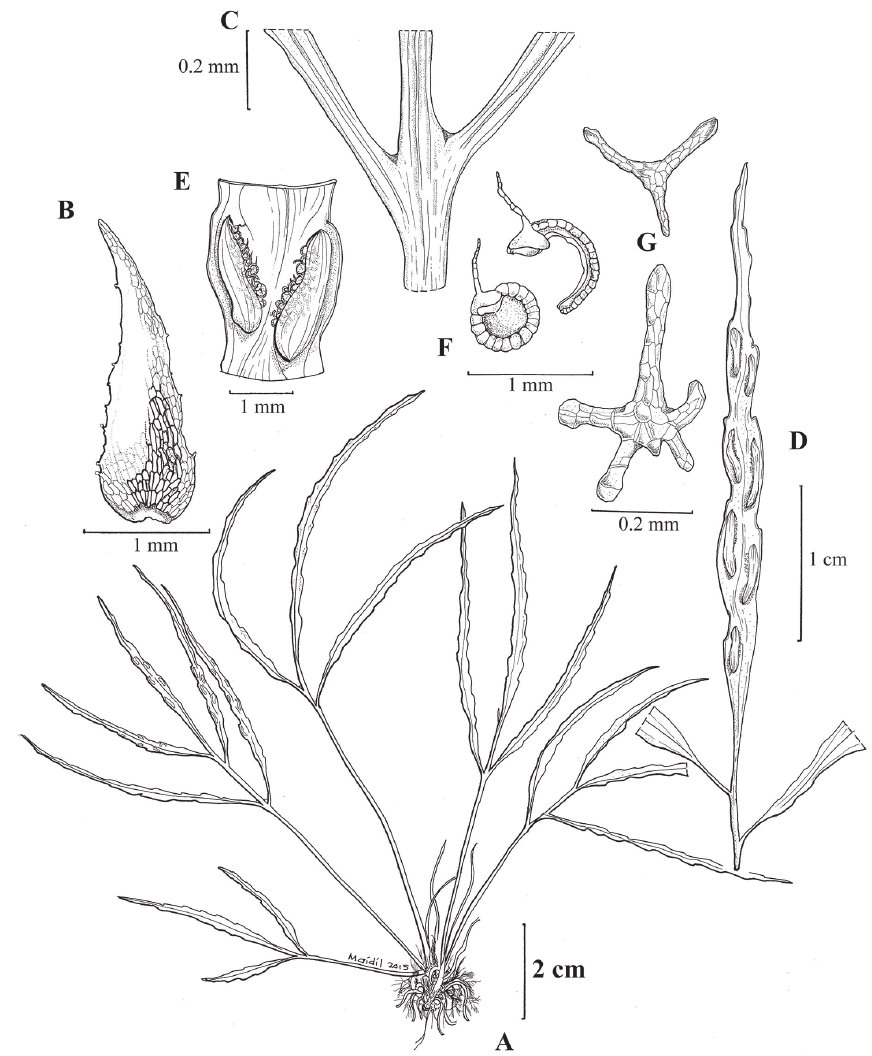
Figure 1. Asplenium merapohense R.Jaman & K.Imin, sp. nov. A habit B rhizome scale C rachis with slight- ly winged axils D pinna with sori E sori with sporangia F sporangia before and after dehiscence G 3- and 5-armed scales on lower pinna surface. (Drawn by Mohamad Aidil Noordin from Imin et al. FRI